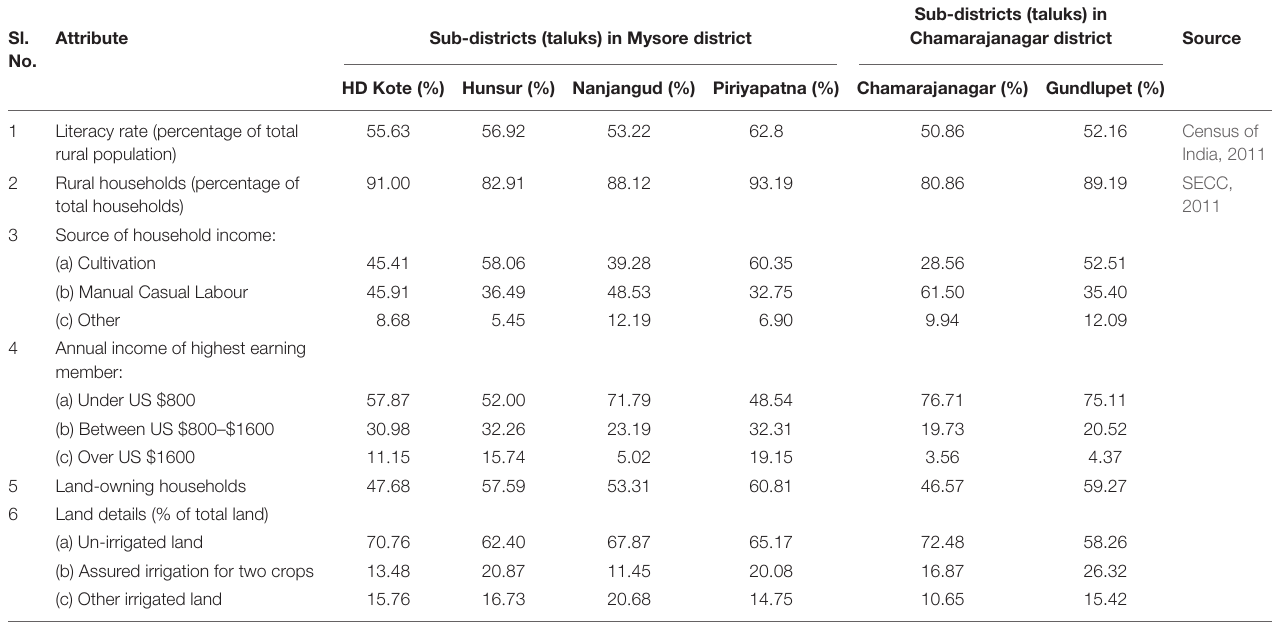
TABLE 1 | Socio-economic information, as a percentage of rural households (unless specified) in the program implementation area surrounding the Nagarahole and Bandipur National Parks.